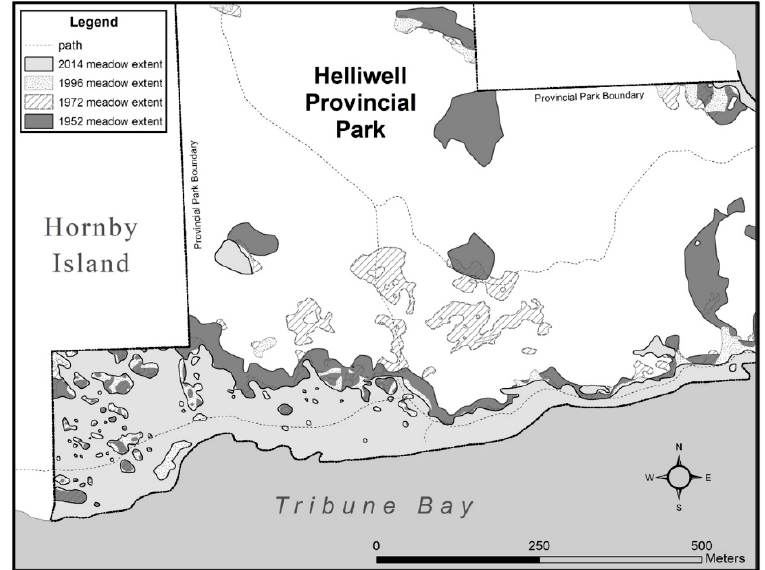
Figure 5. Repeat Aerial photographs from 1952 to 2014 depict spatial changes in the extent of the Garry oak maritime meadow located in the southwest corner of Helliwell Park on Hornby Island, British Columbia, Canada.